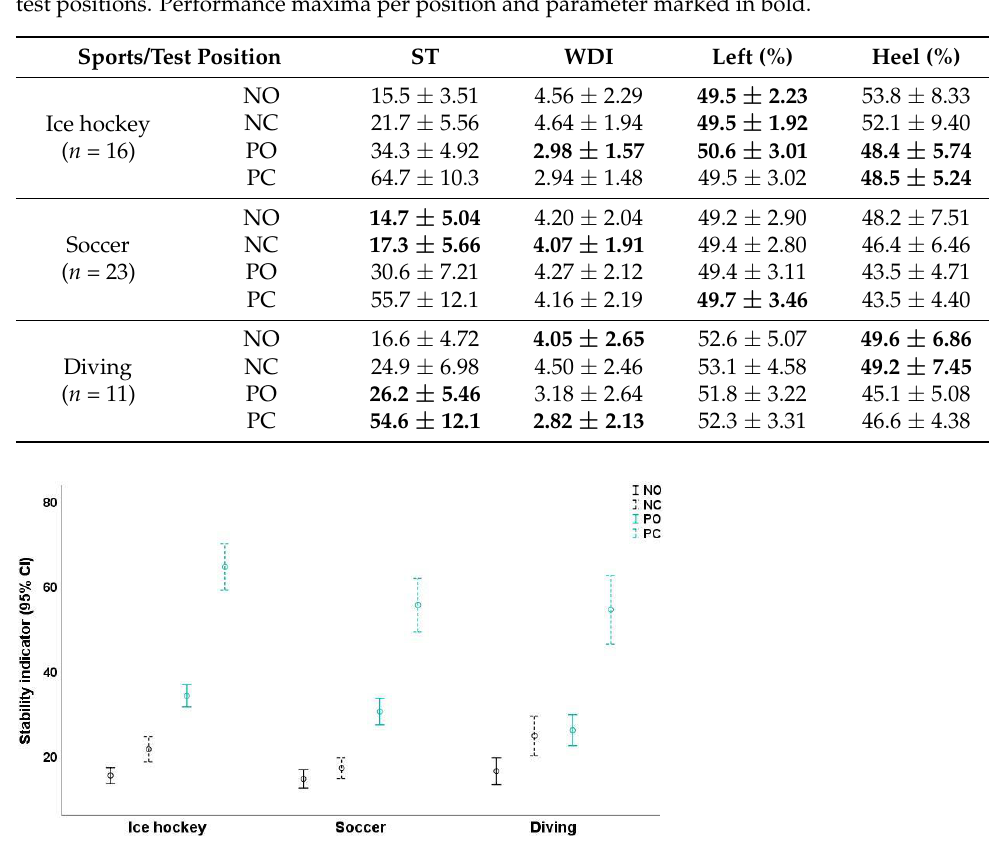
Figure 2. Stability indicators (ST) between sports during four test conditions (NO, NC, PO, PC). Values are provided as mean and 95% CI.